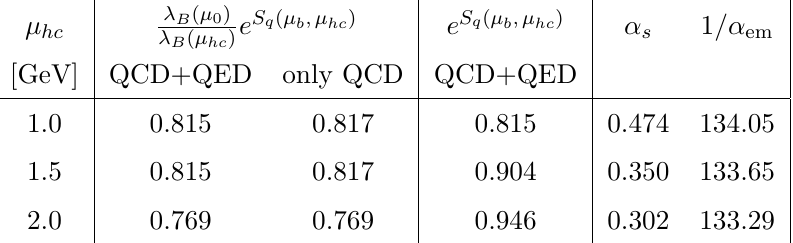
Table 2. The size of the SCET I Sudakov factor for (cid:12)xed (cid:22) b = 5 : 0 GeV and three di(cid:11)erent choices of (cid:22) hc . The column \only QCD" shows the e(cid:11)ect when setting (cid:11) em = 0 in the cusp